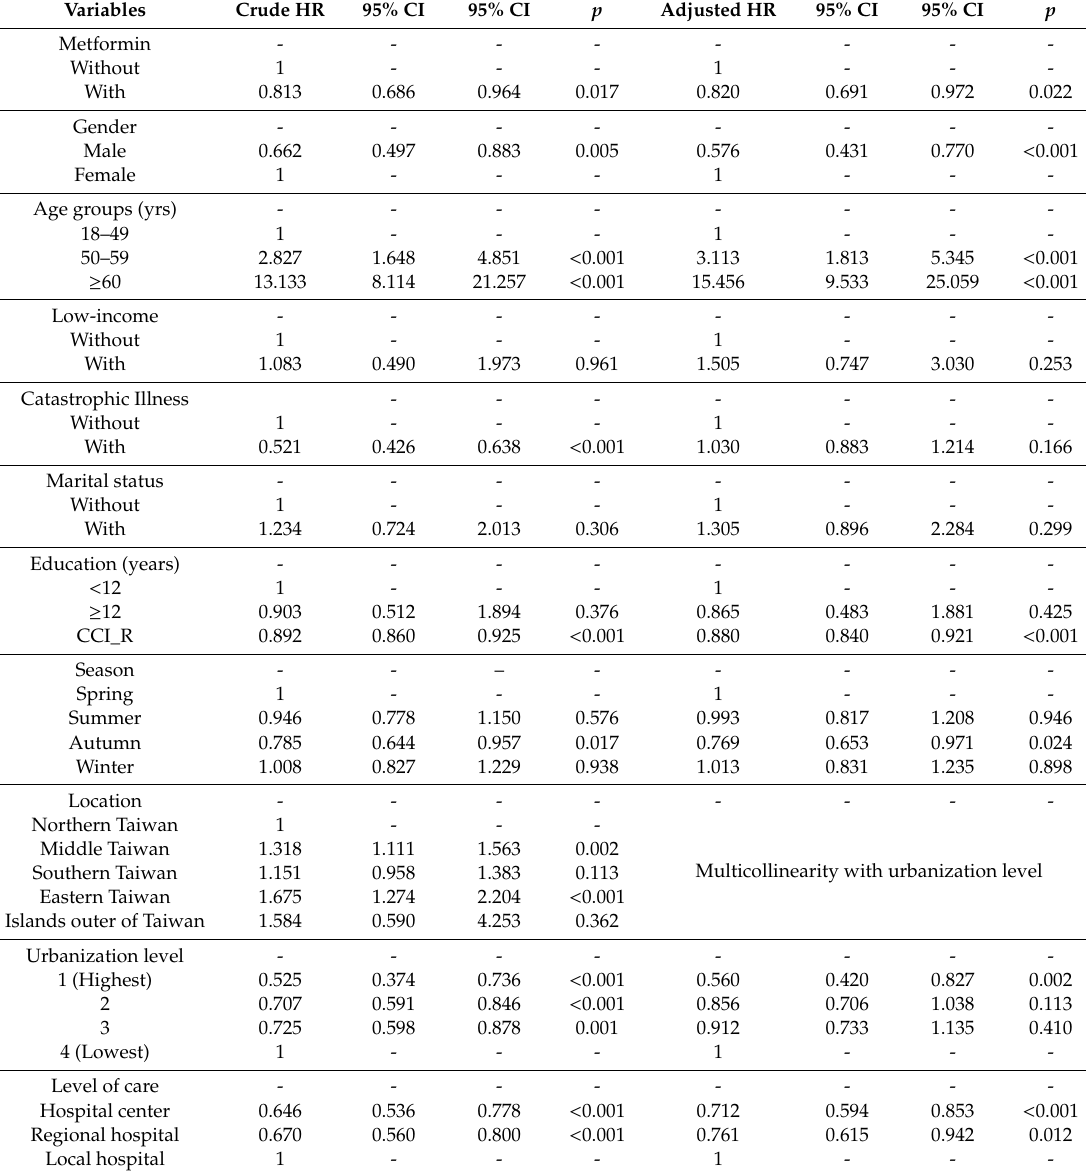
Table 3. Factors of osteoporosis by using Cox